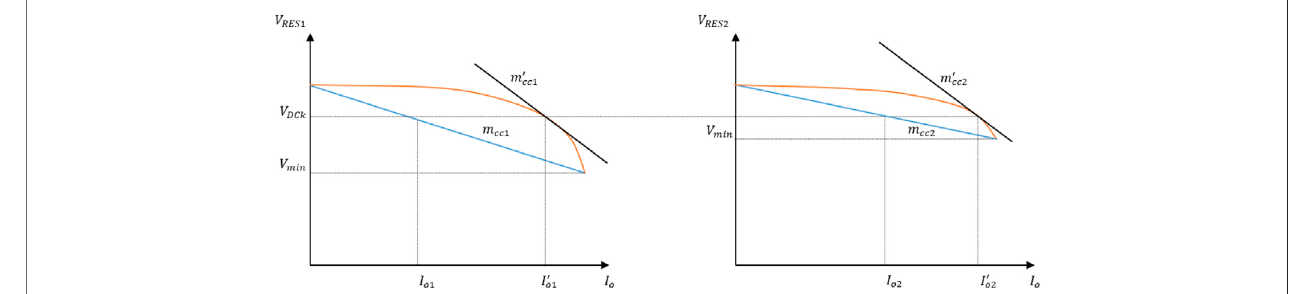
FIGURE 8 | Performance comparison of the linear droop control and the non-linear droop